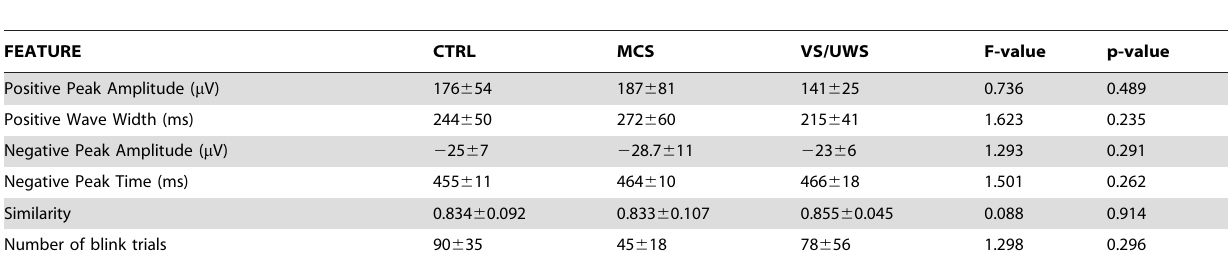
Table 2. Descriptive statistics (mean 6 2*standard error) and results of ANOVAs with GROUP as a between-subject effect are presented for six parameter describing the EOG blink (significances of F-values are estimated on the basis of permutation